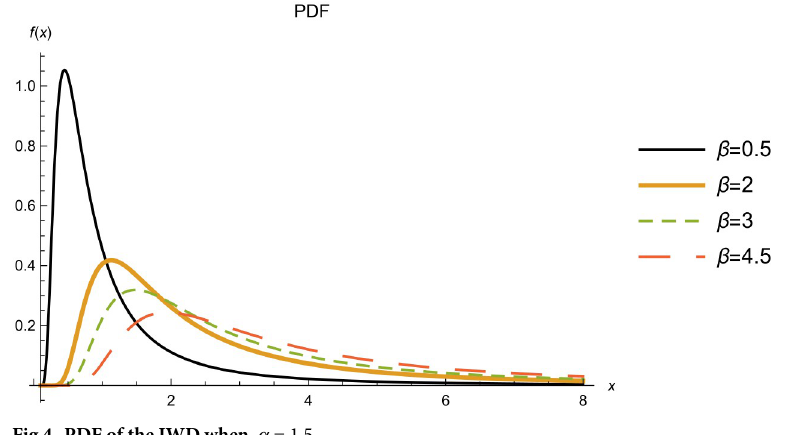
Fig 4. PDF of the IWD when. α =